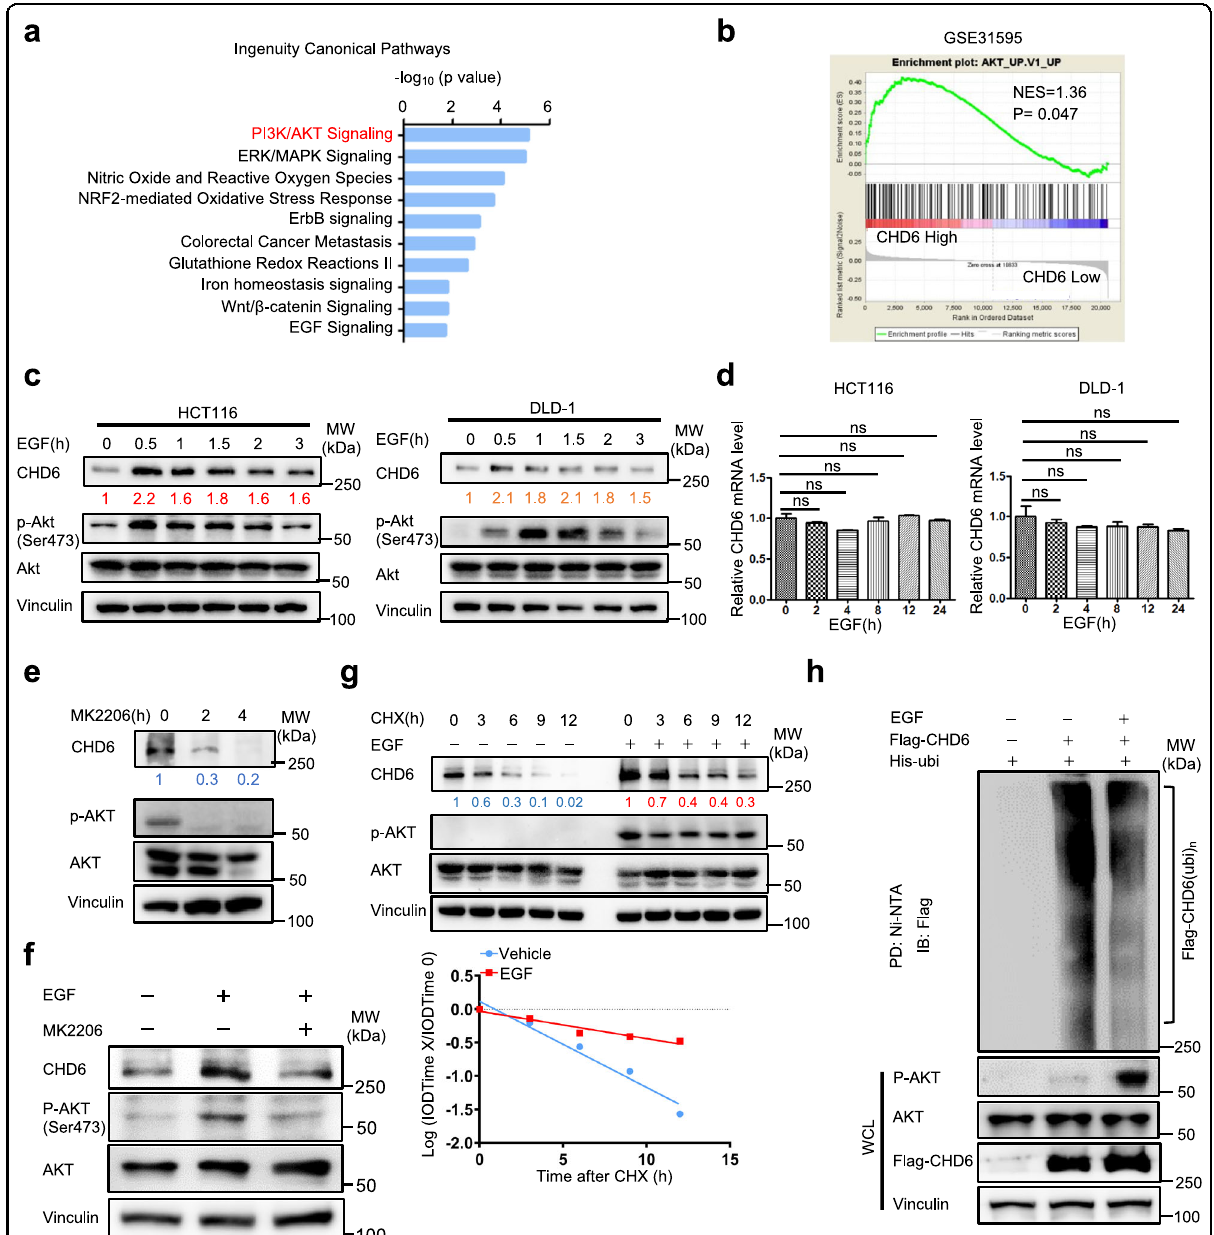
Fig. 2 EGF increases CHD6 stability. a Ten cancer-related pathways that were signi fi cantly associated with genes affected by CHD6 in CRC (GSE2109 and GSE14333). Hallmark pathways emerged following IPA ‘ core analysis ’ . Enrichment scores were displayed as − log 10 ( P value) by Fisher ’ s exact test. b GSEA plot of AKT signaling pathway signature correlated with CHD6 highly related genes. Normalized enrichment score (NES) and nominal P value of correlation were shown. c Representative immunoblot analysis of the indicated proteins in HCT116 and DLD-1 cells treated with EGF (100ng/mL) at the indicated time points. d CHD6 mRNA levels in the indicated cells treated with EGF (100 ng/mL) for the indicated hours. ns, not signi fi cant. e Representative immunoblot analysis of the indicated proteins in HCT116 cells treated with MK2206 (5 μ M) at different time points. f Representative immunoblot analysis of the indicated proteins in HCT116 cells treated with or without MK2206, followed by EGF treatment. g Representative immunoblots showing CHD6 protein turnover rate in HCT116 cells treated with cycloheximide (CHX, 60 μ g/mL), in the presence or absence of EGF (100ng/mL) treatment (top). Quanti fi cation of g (bottom). IOD, integrated optical density. The relative density of CHD6 was normalized to Vinculin and then normalized to the t = 0 control. h Representative immunoblots showing ubiquitination of Flag-tagged CHD6, under EGF (100 ng/mL) treatment in 293T cells. Cells were treated with MG132 (10 μ M) 6 h before harvest. The cell lysates were pulled down (PD) with nickel beads (Ni-NTA) and immunoblotted with the indicated antibodies. WCL whole cell